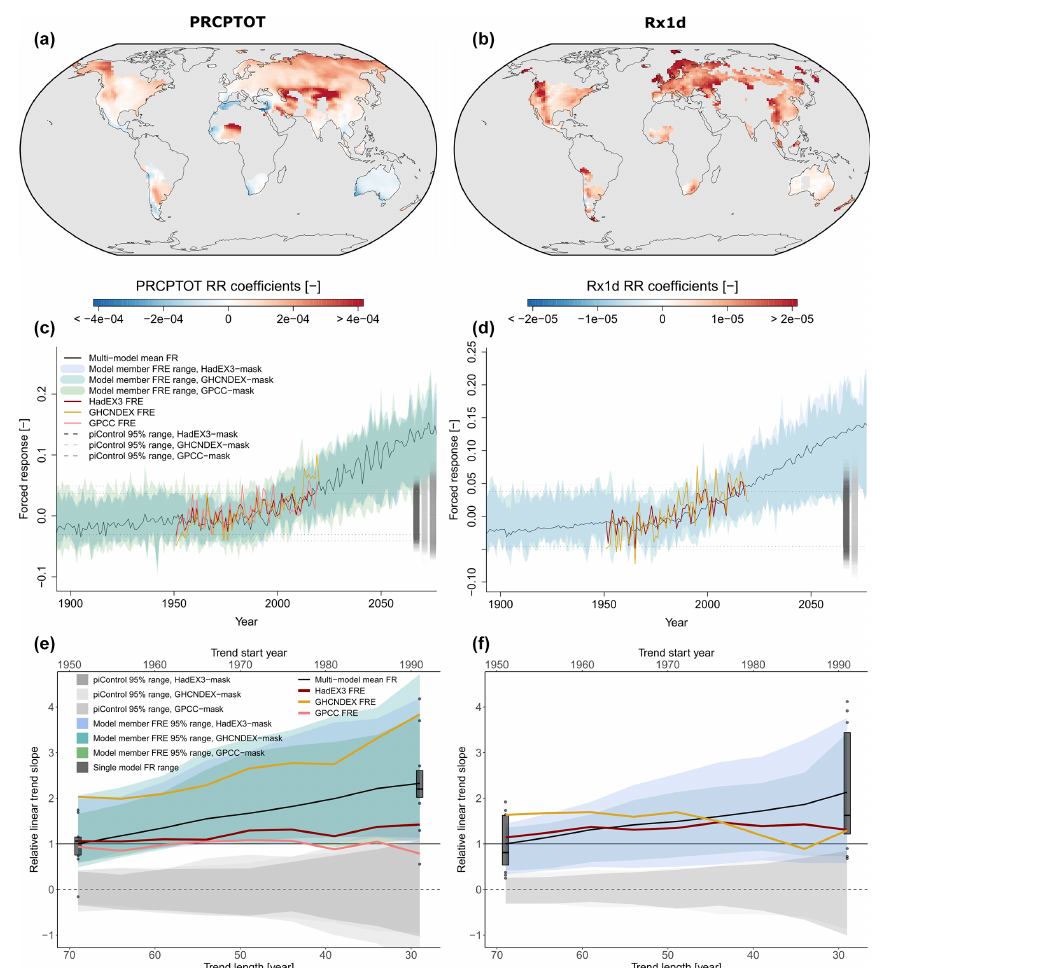
Figure 3. Annual mean total precipitation (PRCPTOT) and extreme precipitation (Rx1d) ridge regression detection fingerprints for HadEX3 coverage (a, b) , corresponding forced response estimates (FREs) (c, d) and linear forced response estimate trends as a function of trend period (e, f) . In (c) and (d) , black lines represent the multi-model forced response (FR) best estimate, coloured shading the full range of model forced response estimates, coloured lines the observed forced response estimate, grey dashed lines the unforced internal variability of the forced response pattern (piControl forced response estimate 95% range (2.5% to 97.5% quantile range)). In (e) and (f) , black lines represent the multi-model forced response best-estimate trend, coloured shading the 95% range of model forced response estimate trends, coloured lines the observed forced response estimate trends, grey shading the piControl trends, black boxplots the model ensemble mean target trends. Trends are computed from a variable start year until the end year of the observational time series (2018 for HadEX3, 2019 for GPCC, 2020 for GHCNDEX, 2018 for multi-model forced response best estimate and model ensemble mean trend). Start years vary between 1951 and 1991 with increments of 5 years. piControl trends are computed over periods equally long as the corresponding forced trends. All linear trends are normalised with respect to the multi-model forced response best-estimate 1951–2018 trend, i.e. the leftmost point on the black